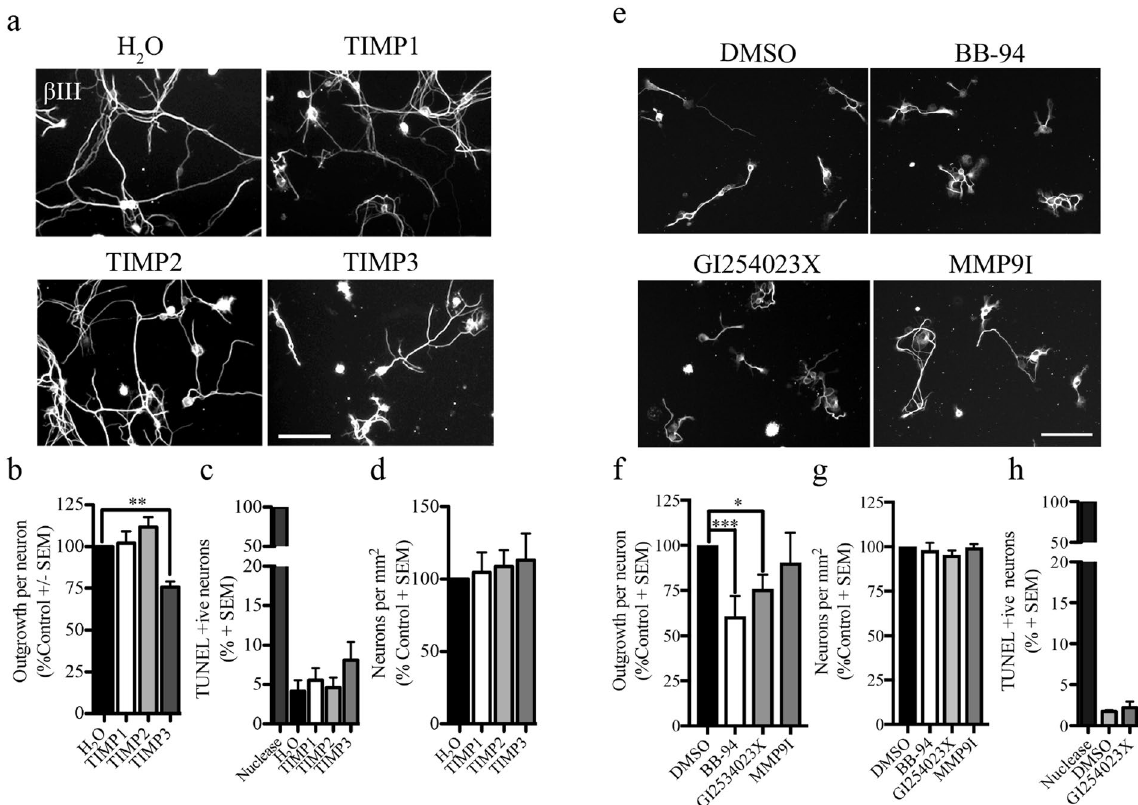
Figure 3. ADAM proteolytic activity is necessary for embryonic DRG growth. ( a ) Embryonic DRG neurons seeded on a PLL substrate and treated with control (H 2 O), or endogenous metalloproteinase inhibitors (TIMP1- 3). Neuronal projections were visualized with β III-tubulin staining. ( b ) Neurite outgrowth quantification of embryonic DRG neurons exposed to soluble recombinant TIMPs and control conditions. Data have been normalized to control condition. ( c ) TUNEL assay was performed in embryonic DRG neurons treated with TIMPs or H 2 O control. DNA nuclease was used as a positive control. Data are shown as a percentage of TUNEL-positive neurons. ( d ) Number of neurons present on the PLL substrate after treatment with soluble TIMPs and control condition. ( e ). Embryonic DRG neurons exposed to DMSO as a control, a selective ADAM10 inhibitor, GI254030X, BB-94 or a selective MMP9 inhibitor (MMP9I). ( f – h ) Quantification of neurite outgrowth ( f ), cell adhesion ( g ) and percentage TUNEL-positive neurons ( h ) following treatment with metalloproteinase inhibitors. For the TUNEL assay the data are shown as a percentage of TUNEL-positive neurons. For total number of neurons, data have been normalized to control DMSO or H 2 O. N = 3–4 from independent cultures. Data are shown as mean + S.E.M. * p < 0.05, ** p < 0.01, *** P < 0.001by one-way ANOVA followed by Bonferroni post hoc test. Scale bar, 100 μ